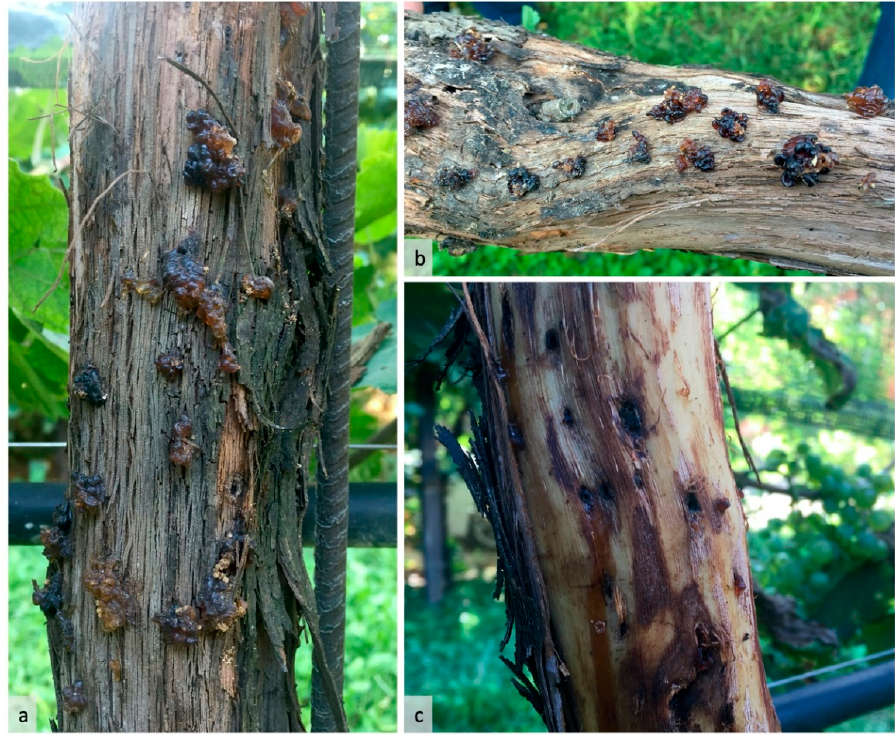
Figure 3. Infestation of Xylosandrus germanus on Vitis vinifera associated with the emission of gum ( a , b ). Decorticated grapevine presenting dark brown-black staining of the wood in correspondence to the tunnels of X. germanus ( c ) .